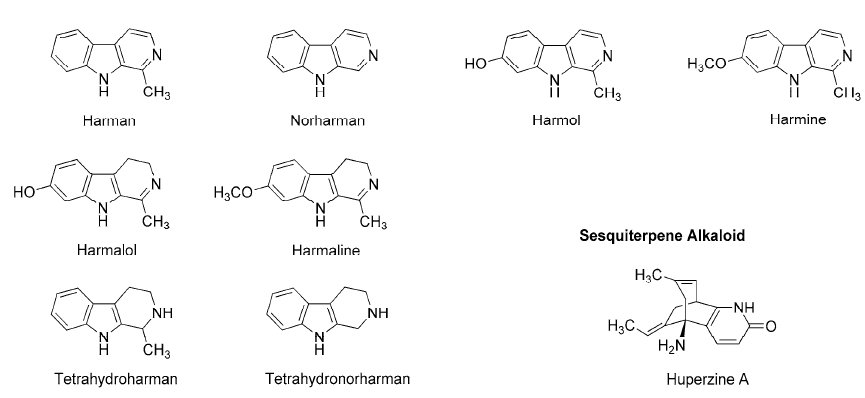
Figure 7. Alkaloids with the general anesthetic activity.